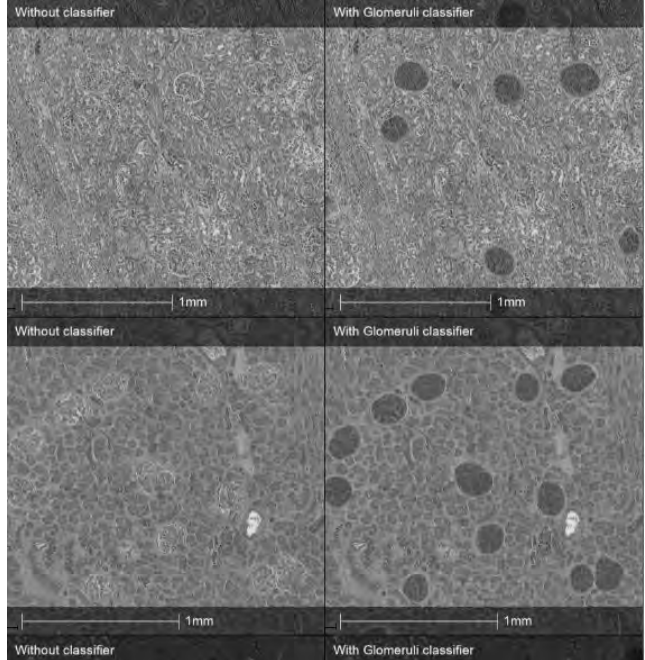
Figure 2: Glomeruli counting by halo Results: Out of 1166 forensic autopsies, 86 met all inclusion criteria (54 men). Mean±SD age was 43.5 ±14.6 y, women were slightly older (49.0±12.0 vs 40.2 ±15.2 years, p <0.0062); 786±277 glomeruli were analyzed per participant. There was no significant difference in GD between men and women (2.18 ± 0.49 vs 2.29± 0.57 glomeruli/mm 2 , p = 0.71). Glomerular area and diameter also did not differ. GD correlated inversely with kidney weight (r = -0.36, p 0.0007), glomerular area (r = - 0.59 p = 0.0000) and age (in women, r = -0.48 p = 0.005). Glomerular area increased with age (r = 0.35 p =